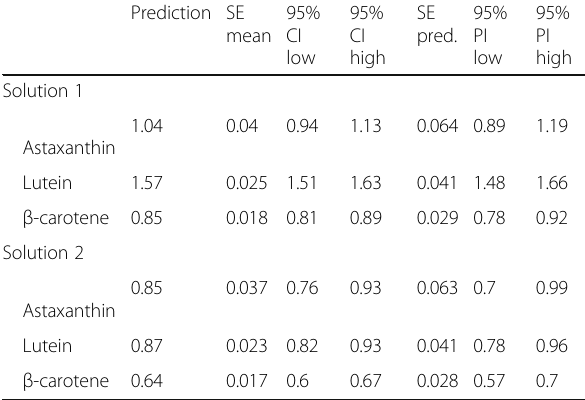
Table 4 Statistical analysis of the predicted